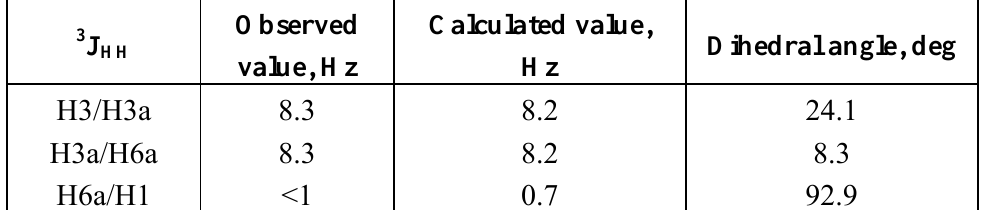
Table 2. Experimental and calculated proton coupling constants for compound 5b